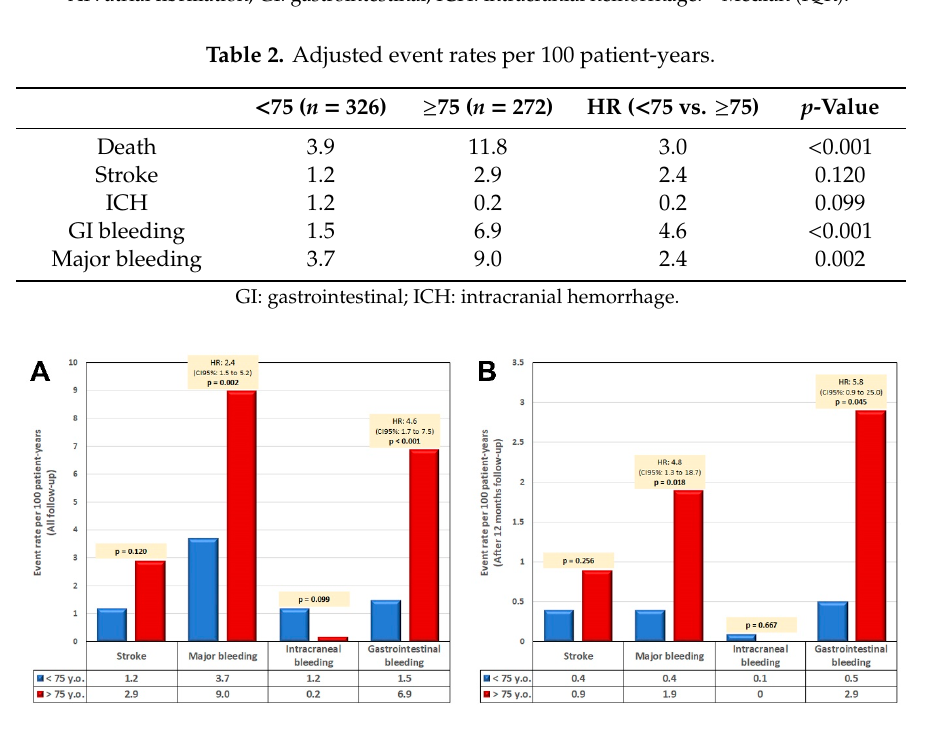
Table 1. Clinical variables in the populations aged < 75 and ≥ 75 years.